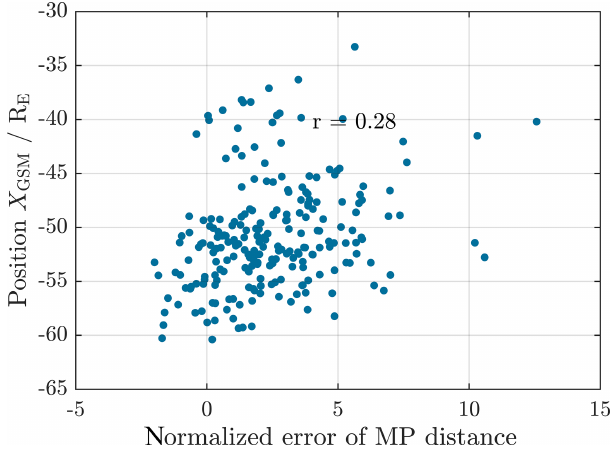
Figure 7. Example for non-existent correlation between the normal- ized MP distance and the position of the MP crossing projected onto the x GSM axis for outermost crossings. The correlation coefficient is only r = 0 .